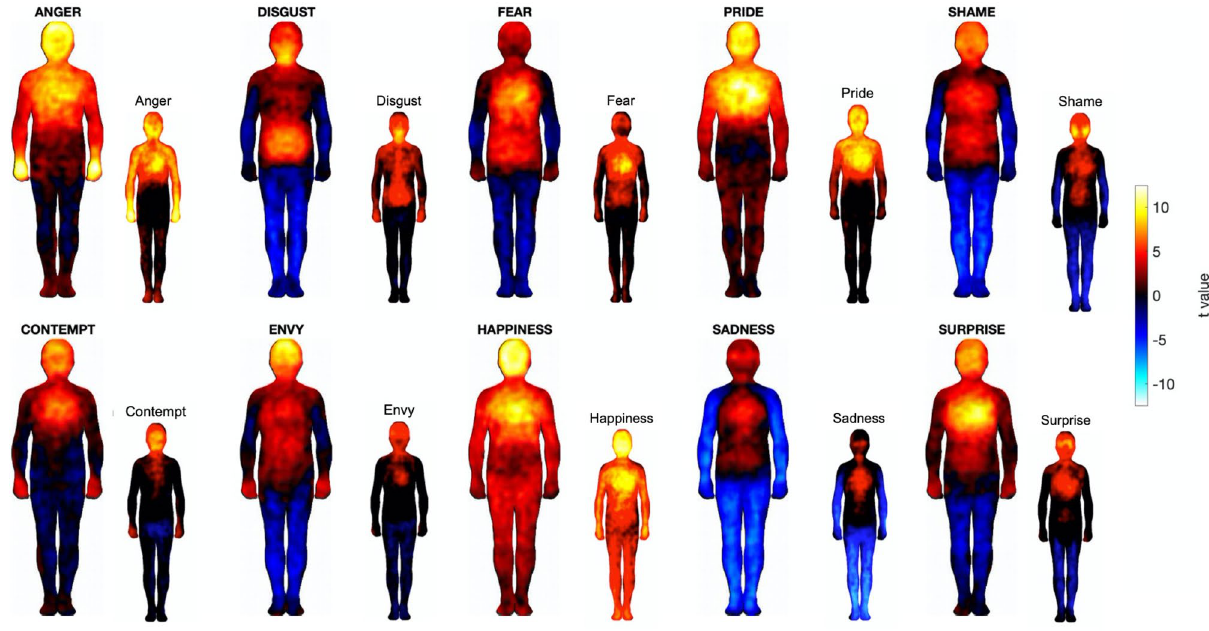
Figure 5. Group-level t maps for the bodily sensation maps analyzed in the present study. Large silhouettes show t-statistics from a t-test against zero calculated at each pixel in the body maps. Small silhouettes show the corresponding maps from Nummenmaa et al. 12 , to indicate